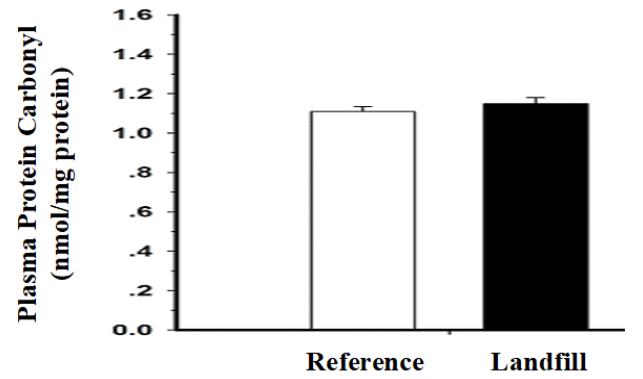
Figure 5. The levels of plasma protein carbonyl (PC) in both groups of the hybrid catfish. Values are expressed as the mean ± standard deviation of 10 fish.